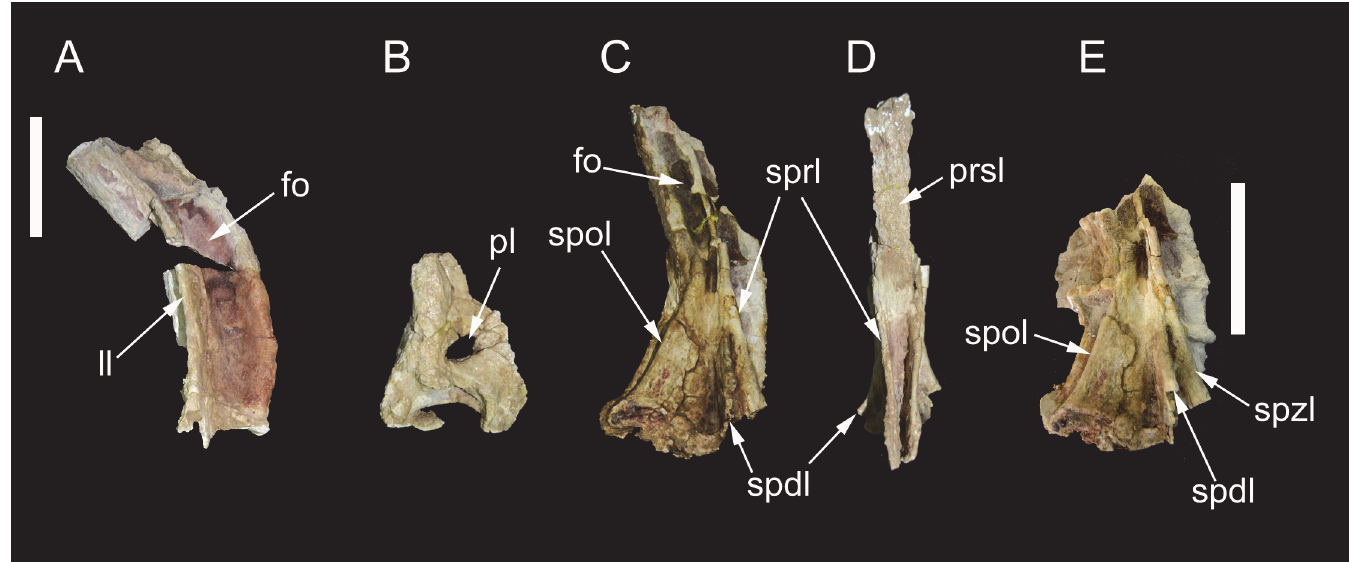
Fig 7. Partial proximal caudal vertebrae of Tataouinea hannibalis . Partial caudal neural spine 1 in right lateral view (A). Partial caudal centrum 1 in right lateral view (B). Partial neural arch 3 in right lateral (C) and proximal (D) views. Partial caudal neural arch 4 in right lateral view (E). Scale bars: A-D: 10 cm, E: 10 cm. Abbreviations: fo, fossa; ll, lateral lamina; pl, pleurocoel; prsl, prespinal lamina; spdl, spinodiapophyseal lamina; spol, spinopostzygapophyseal lamina; sprl, spinoprezygapophyseal